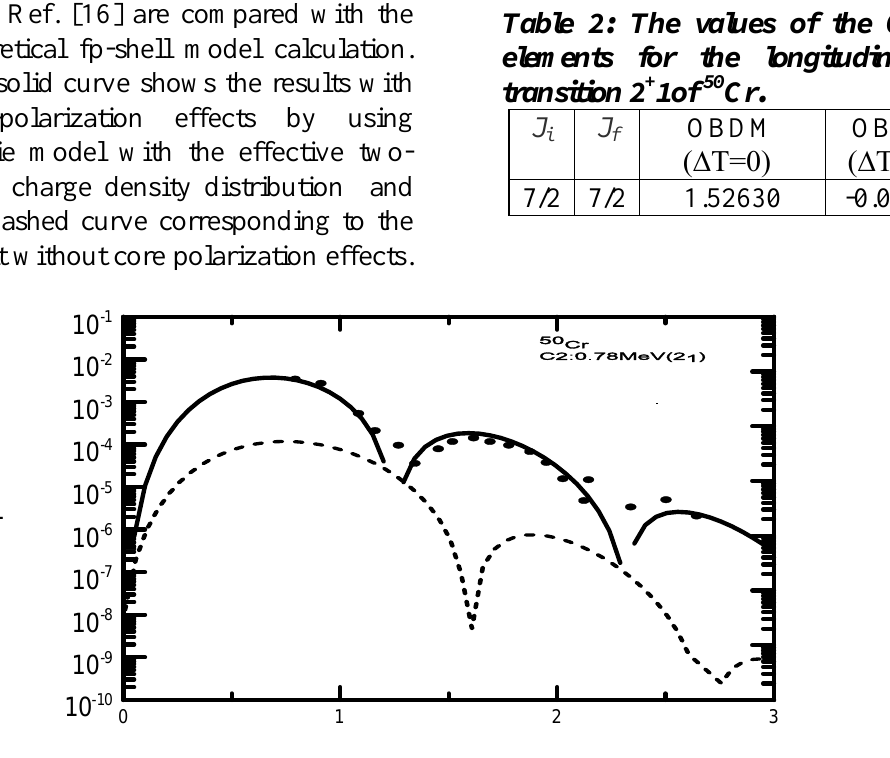
state in the 50 Cr with 𝟏𝟏+ 𝟐𝟐